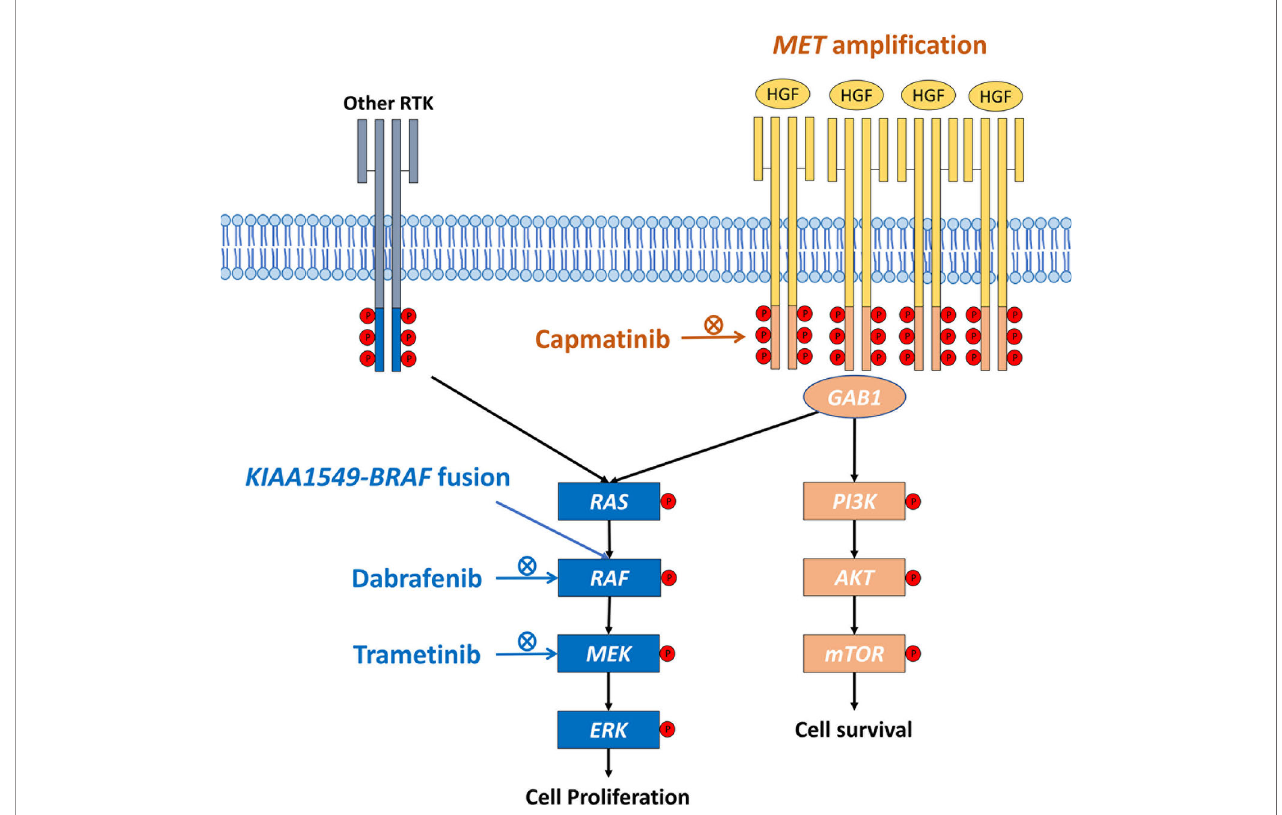
FIGURE 3 | Schematic diagram of the cross-reactivity of BRAF fusion and MET ampli fi cation. HGF, hepatocyte growth factor; RTK, receptor tyrosine